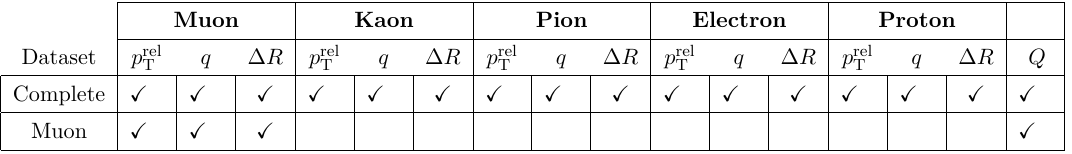
Table 1. Summary of the features contained in the two